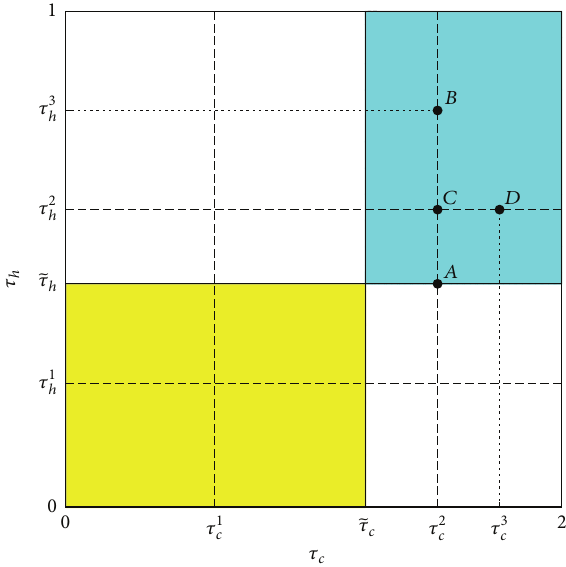
Figure 4: Stability switching